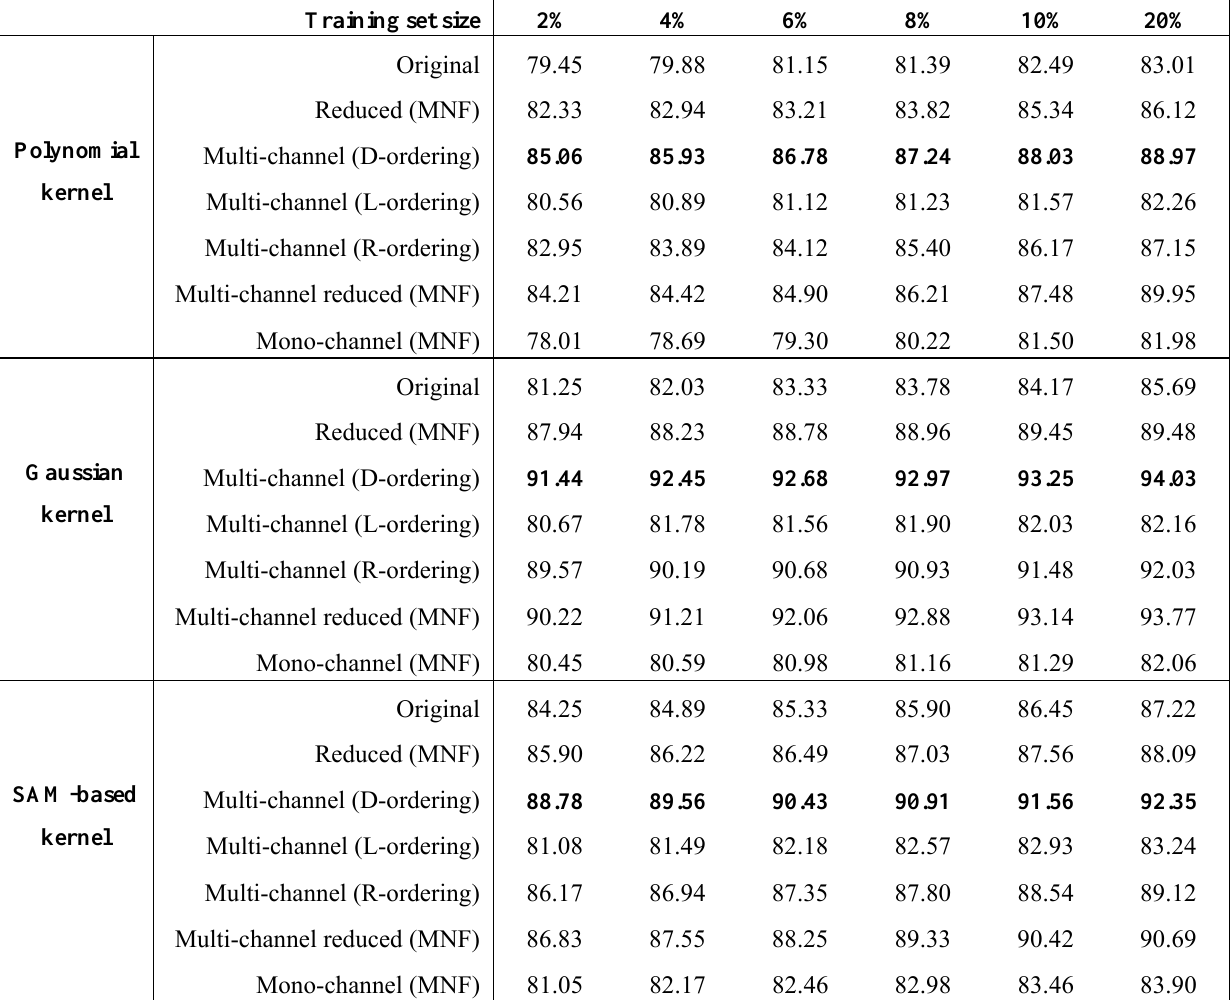
Table 1. Overall classification accuracies (in percentage) obtained after applying the proposed SVM classification system (with polynomial, Gaussian and SAM-based kernels) to mono-channel and multi-channel morphological profiles built for the Salinas AVIRIS scene with 190 spectral bands. Results using the original spectral information and a reduced version of the original scene (obtained after applying the MNF transform and retaining the first 16  p components) are also